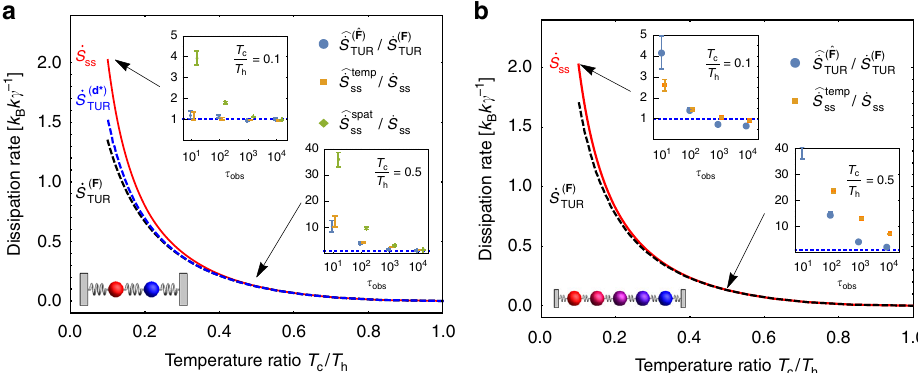
Fig. 4 Performance of dissipation rate estimators. Data are shown both for the model with two beads ( a ) and the higher-dimensional model with fi ve beads ( b ). The TUR bound with d = F (dashed black line) becomes tighter to the actual dissipation rate (solid red line) when the dynamics is closer to equilibrium ( T c / T h → 1) and in the limit of many beads. Inset plots show the estimator convergence rates for temperature ratios of 0.1 and 0.5, with error bars reporting standard error, computed from 10 independent samples. The blue dashed line in a is the TUR bound resulting from a Monte Carlo optimization scheme, as described further in Fig. 5. The bottom right inset of b re fl ects that the TUR estimator may be useful as a practical proxy for the entropy production rate